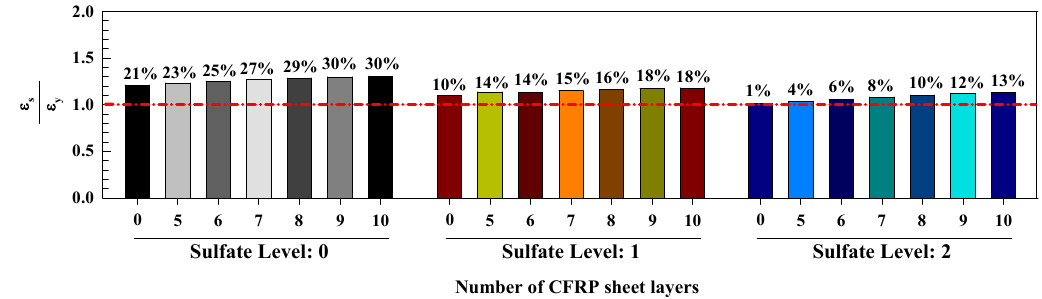
Figure 13. Investigated parameters versus maximum steel